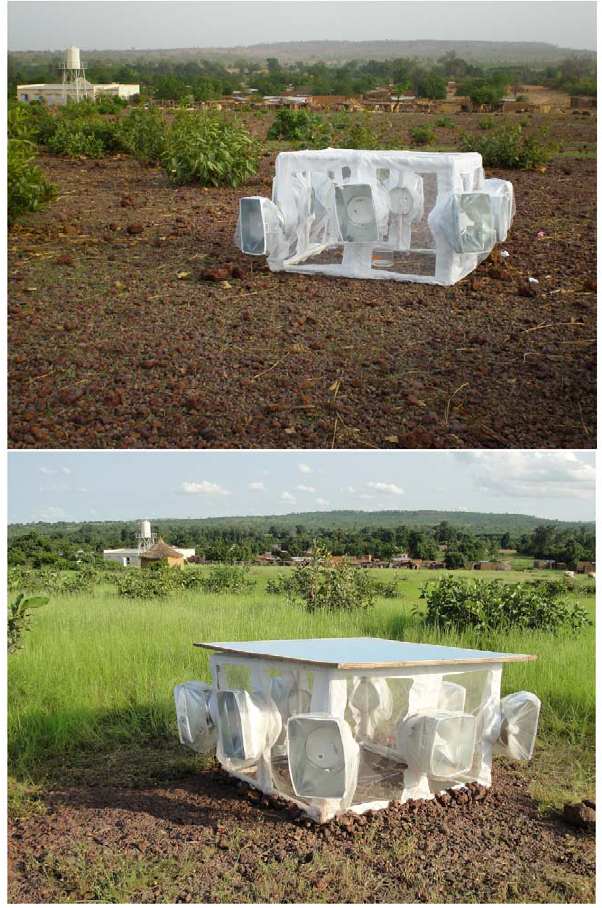
Figure 2. ‘‘Marche’’ site, North-West edge of Done´gue´bougou. Upper panel, dry season (April 2009); lower panel, wet season